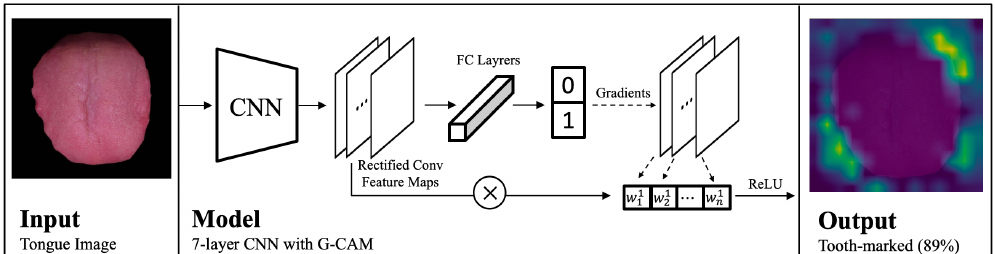
Figure 2. Our method is designed to output the probability of a tooth-marked tongue and localize regions in the image most indicative of the pathology. In this example, given a tongue image as input, we forward-propagate the image through the Convolutional Neural Network (CNN) and then compute a raw score (89%) for the class of tooth-marked tongue. Then, we reset the output to one for tooth-marked tongue predictions while zero for nontooth-marked ones. This signal is further backpropagated to the rectified convolutional feature maps of interest to acquire their corresponding gradients, which we combine to compute the coarse Gradient-weight Class Activation Mapping (Grad-CAM) localization (heatmap) which represents where the model has to look to make the particular